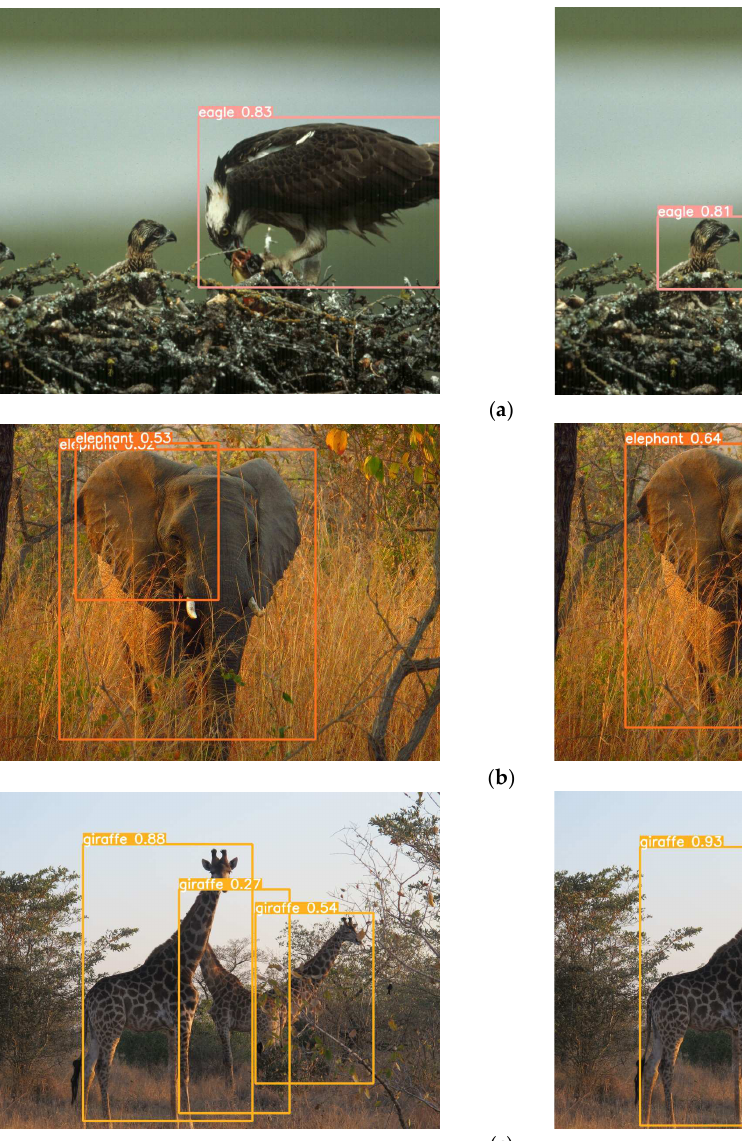
Figure 11. Example of comparison of detection results before and after improvement. ( a ) Detection effect of eagles in the model before and after the improvement; ( b ) Detection effect of elephant in the model before and after the improvement; ( c ) Detection effect of giraffes in the model before and after the improvement. From the comparison diagram in Figure 11a, it can be seen that the original YOLOv5s model does not detect the eagle on the left, while the improved model does not miss the eagle, and the detection accuracy of the original model is further improved. From the